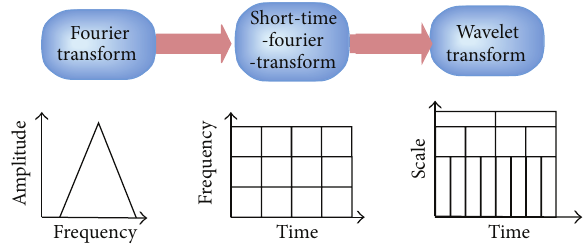
Figure 1: The development of signal